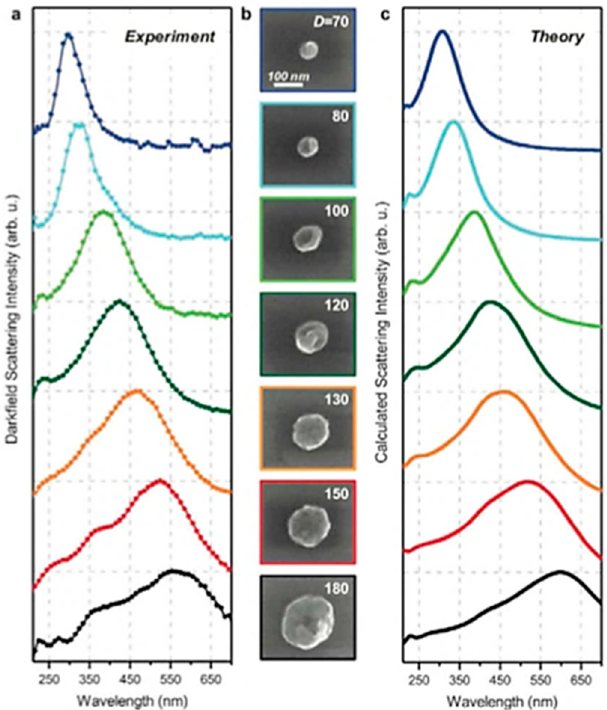
Figure 1. Broadband tunable aluminum plasmonics: ( a ) Experimental spectra; ( b ) electron microscope images; and ( c ) simulated spectra of Al nanoparticles (NPs) with varying sizes. (Adapted from Knight et al. [1]).